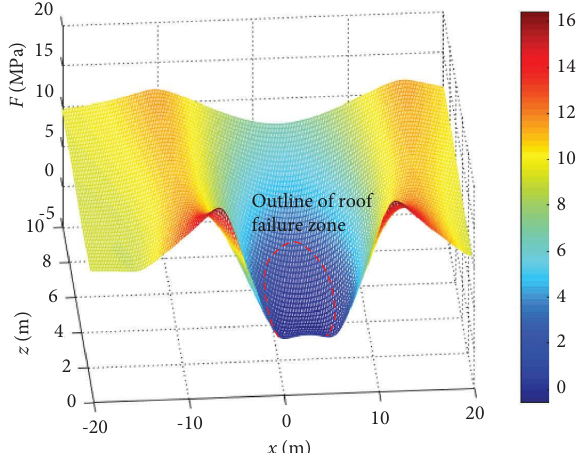
Figure 8: Roof failure characteristics.